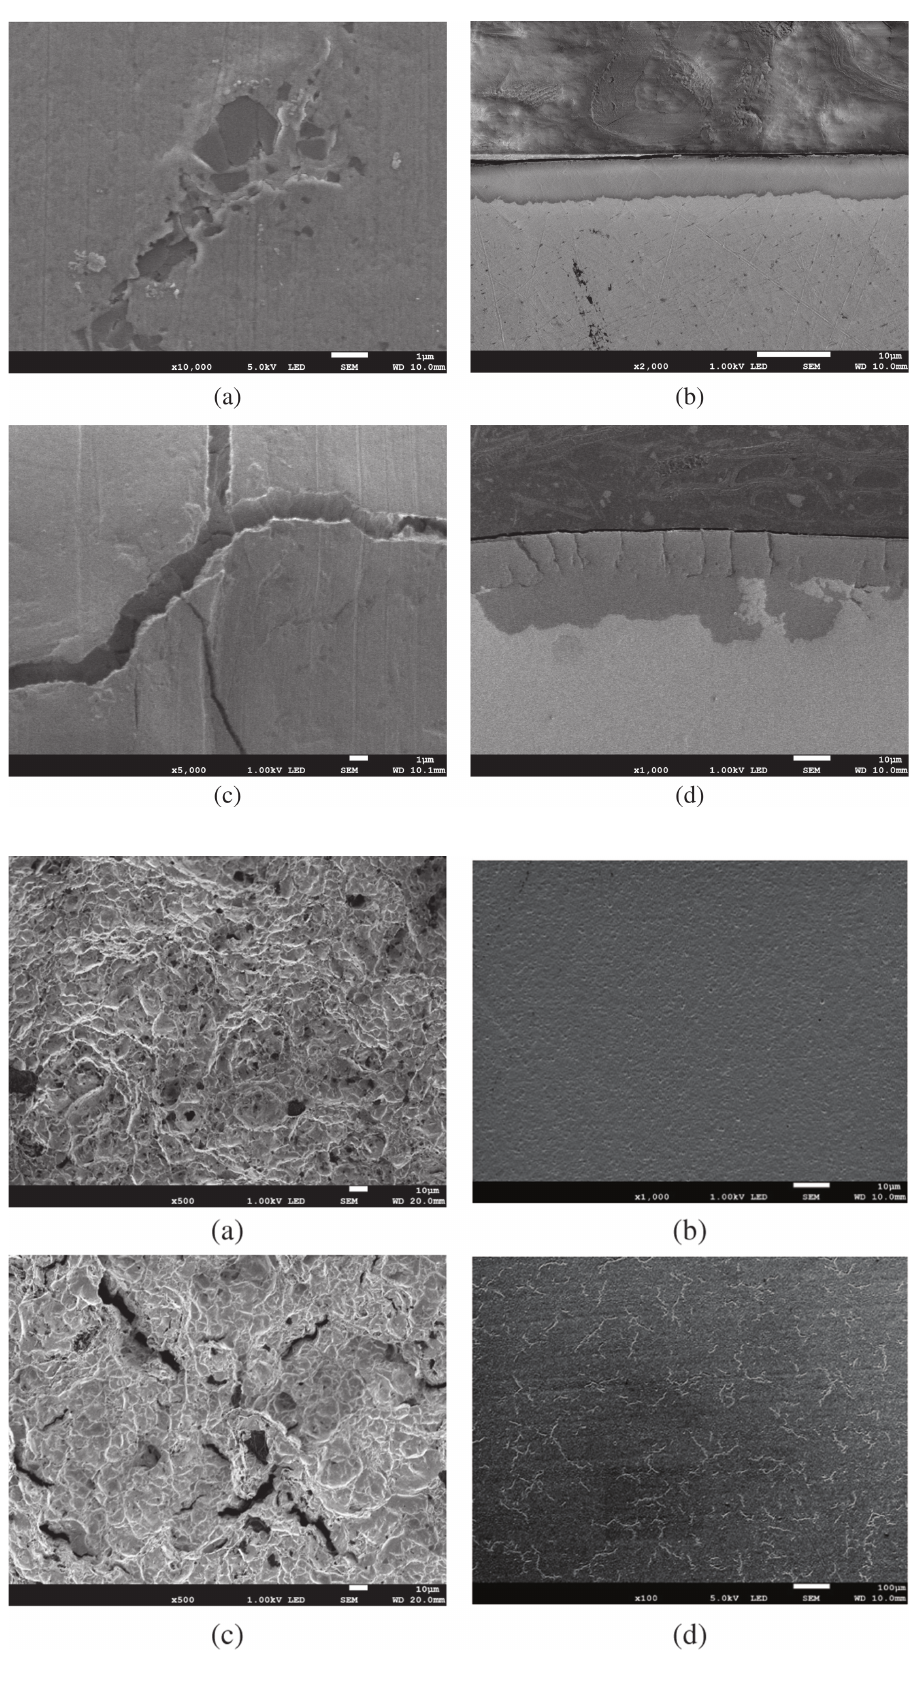
Figure 3: The cross-sections (a, c) and fracture faces (b, d) for the Zircaloy-2 alloy sub- jected to slow strain rate test: reference specimen (a, b) and after oxidization at 350°C for 30 min, hydrogen charging and annealing (c,